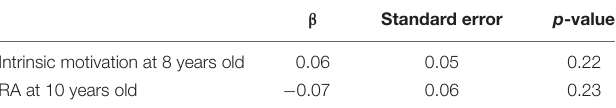
TABLE 8 | Results of gender